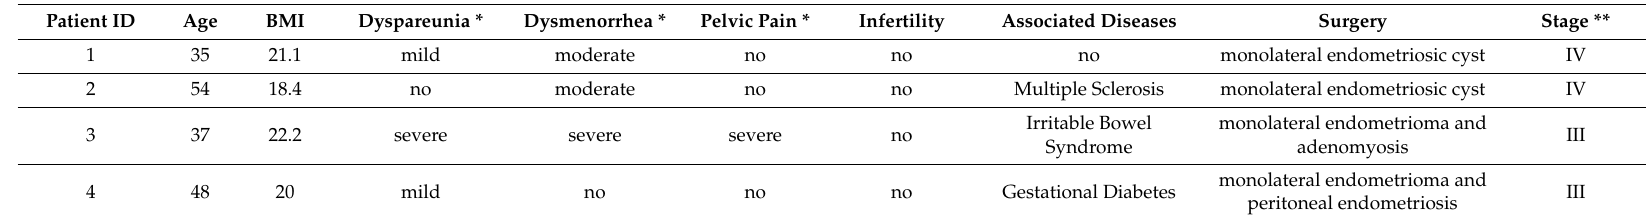
Table 2. Clinical characteristics of patients with TT genotype at TLR4